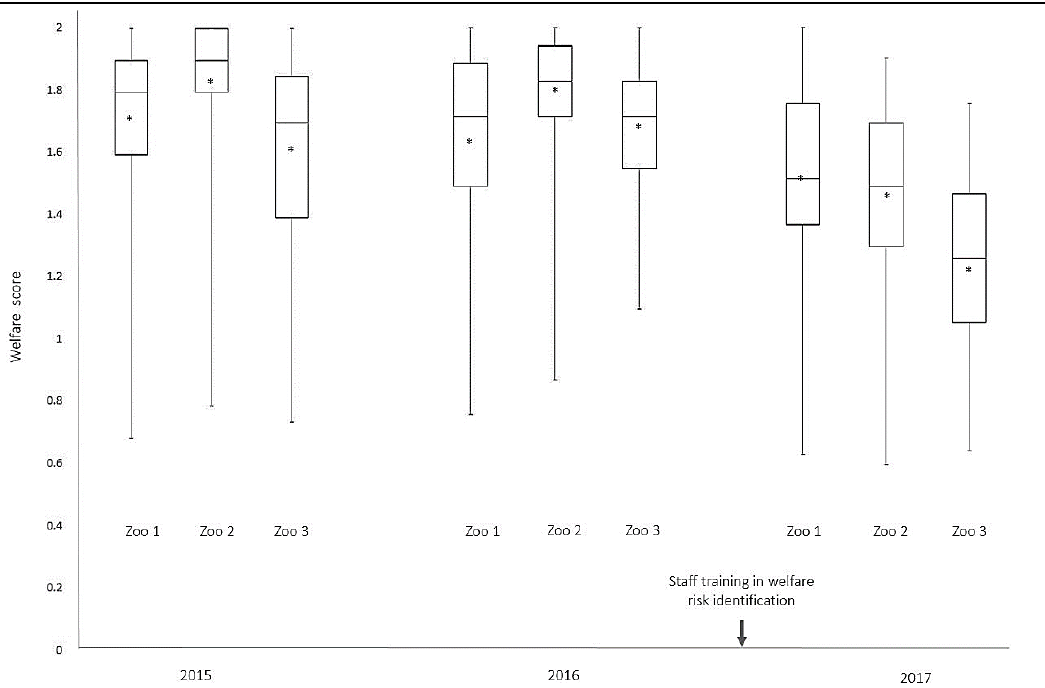
Figure 1. Box plot showing median welfare risk, upper and lower quartiles, the minimum-to-maximum range and mean welfare risk scores (*) at each zoo over the 3-year trial. The higher the welfare score, the lower the risk identified.